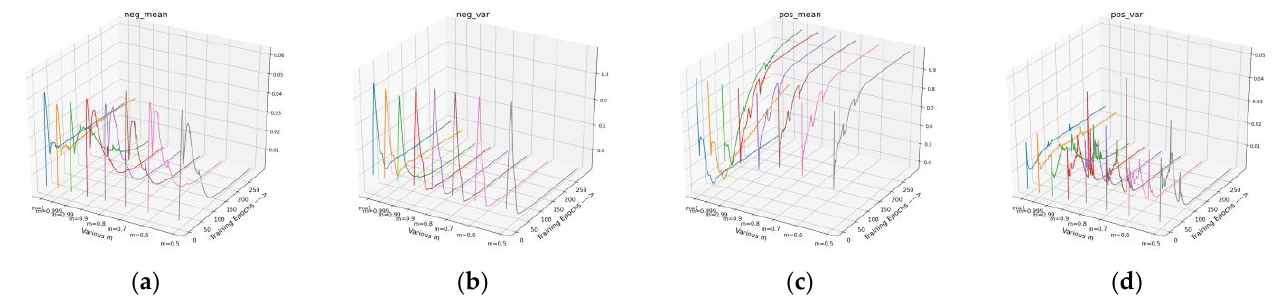
Figure 18. Similarity statistics of various 𝑚 in SCL training on the Pavia University dataset: ( a ) mean of negative similarity; ( b ) variance of negative similarity; ( c ) mean of positive similarity; ( d ) variance of positive similarity. Different colors corresponds to different values of 𝑚 .